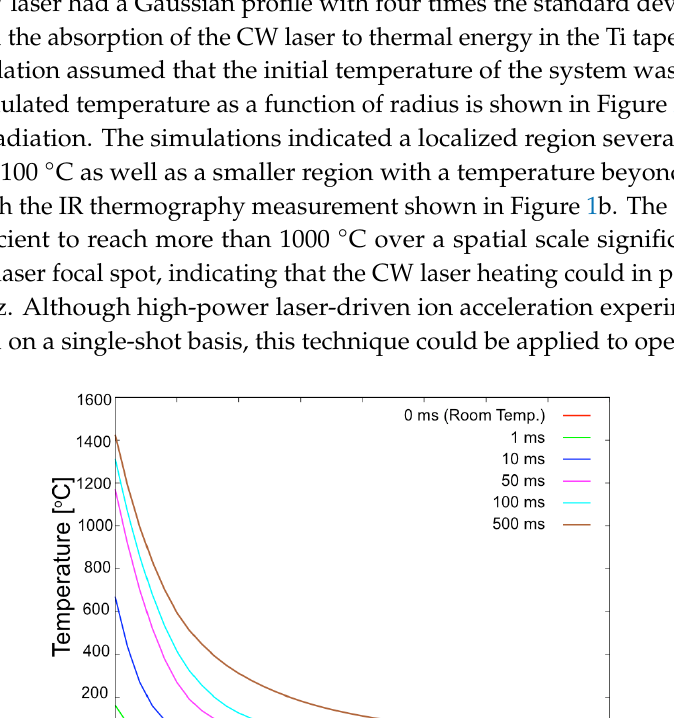
Figure 2. The temperature as a function of radius from the center of the CW laser spot on the tape target, calculated by a time-dependent thermal simulation.